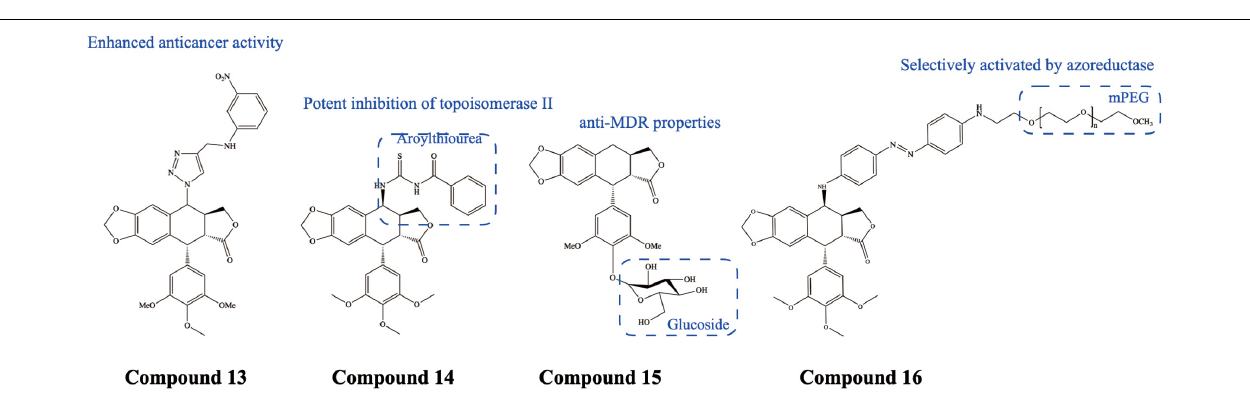
FIGURE 4 | Chemical structures and therapeutic highlights of PTOX derivatives Compound